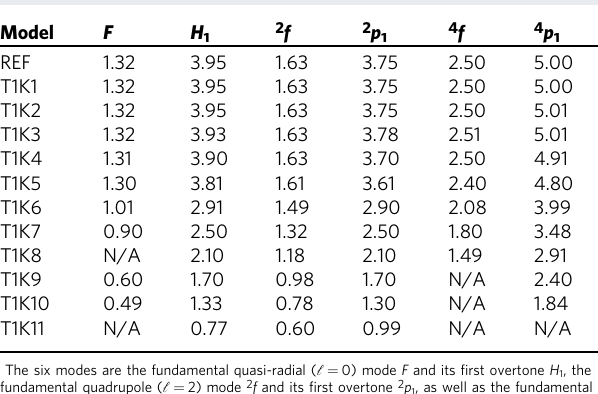
Table 1 Measured eigenfrequencies of the six dominant oscillation modes in the 12 NS models.